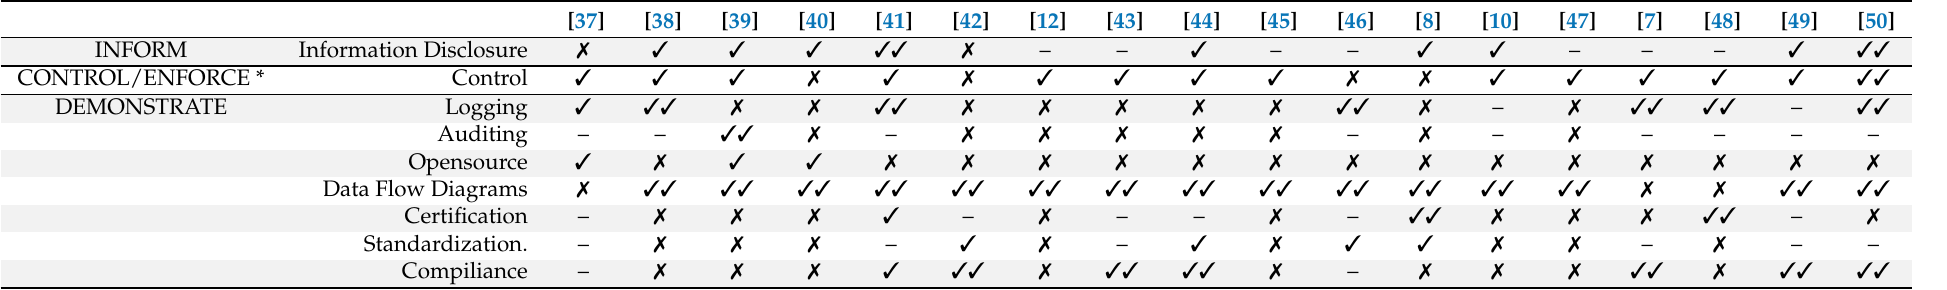
Table 6. Guidelines by Perera et al. [3] for process-oriented strategies applied to the selected articles. (* The guideline for the CONTROL and ENFORCE strategies [3] in the framework are identical in their meaning, which is why we only list